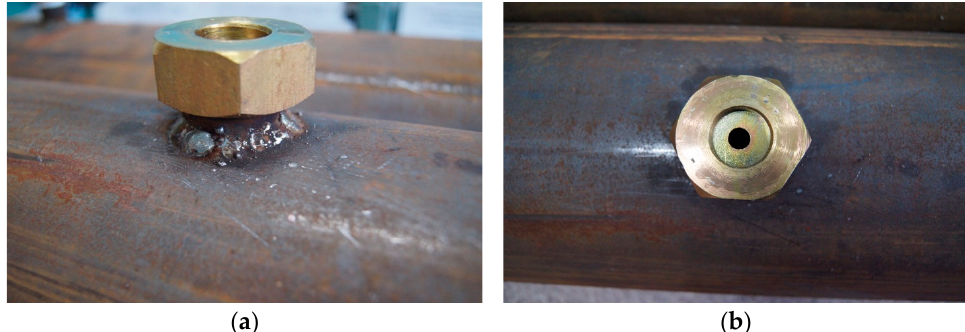
Figure 3. Method of fixing discs on the pipeline: ( a ) side view, ( b ) top view.